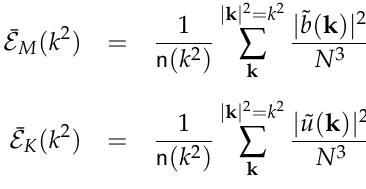
Figure 1. Average magnetic and kinetic energy spectra, ¯ are averages over modes k with the same value of k 2 = k 2 , where 1 k 2 3640, for N = 128. The spectra are shown for times t = 0, 0.01 t end , 0.1 t end ≤ ≤ 0.5 t end and t end , where t end = 1095 for Run 1 and 1037 for Run2b. Spectra are approaching their expectation values and are near equilibrium; they are in true equilibrium when they fully match the ideal expectation